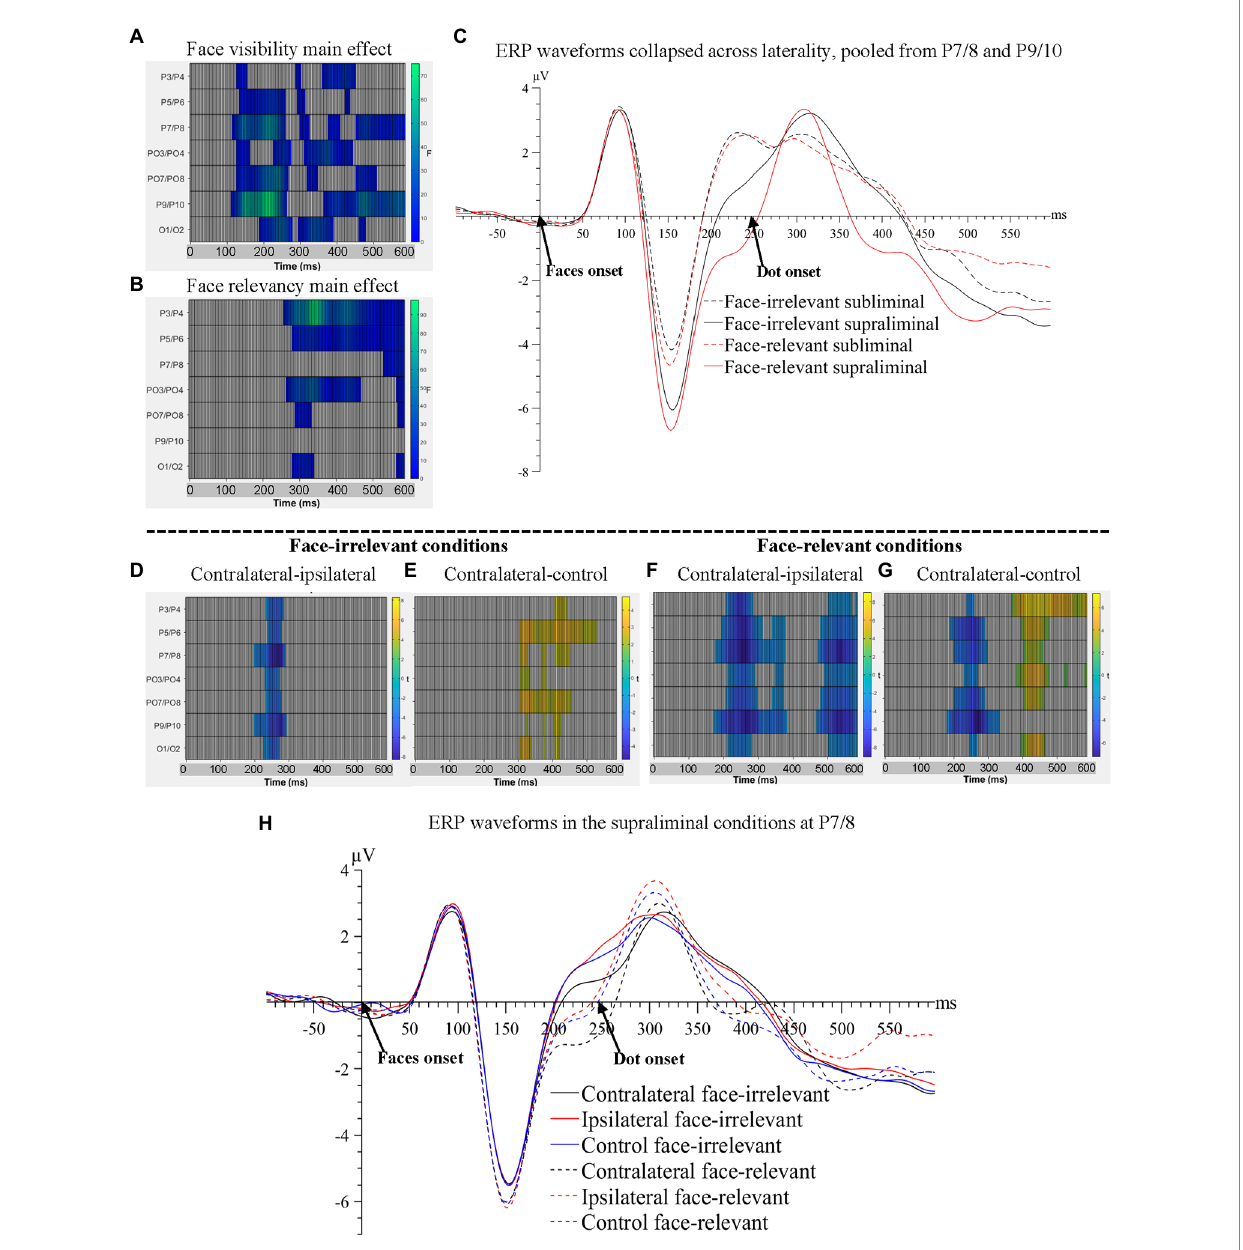
FIGURE 2 Raster plots for (A) the main effect of face-visibility and (B) the main effect of face-relevancy for face-related ERPs. (C) ERP waveforms collapsed across laterality conditions, pooled over P7/8 and P9/10, the two pairs of electrodes that showed the maximal main effect of face-visibility and the maximal interaction effect between face-visibility and face-relevancy. Raster plots for the contrasts between (D) contralateral and ipsilateral signals and between (E) contralateral and control signals, in the face-irrelevant conditions; between (F) contralateral and ipsilateral signals and between (G) contralateral and control signals, in the face-relevant conditions. (H) ERP waveforms for different conditions of laterality and face-relevancy in the supraliminal condition at electrodes P7/8, the pair that showed the maximal interaction effect between laterality and